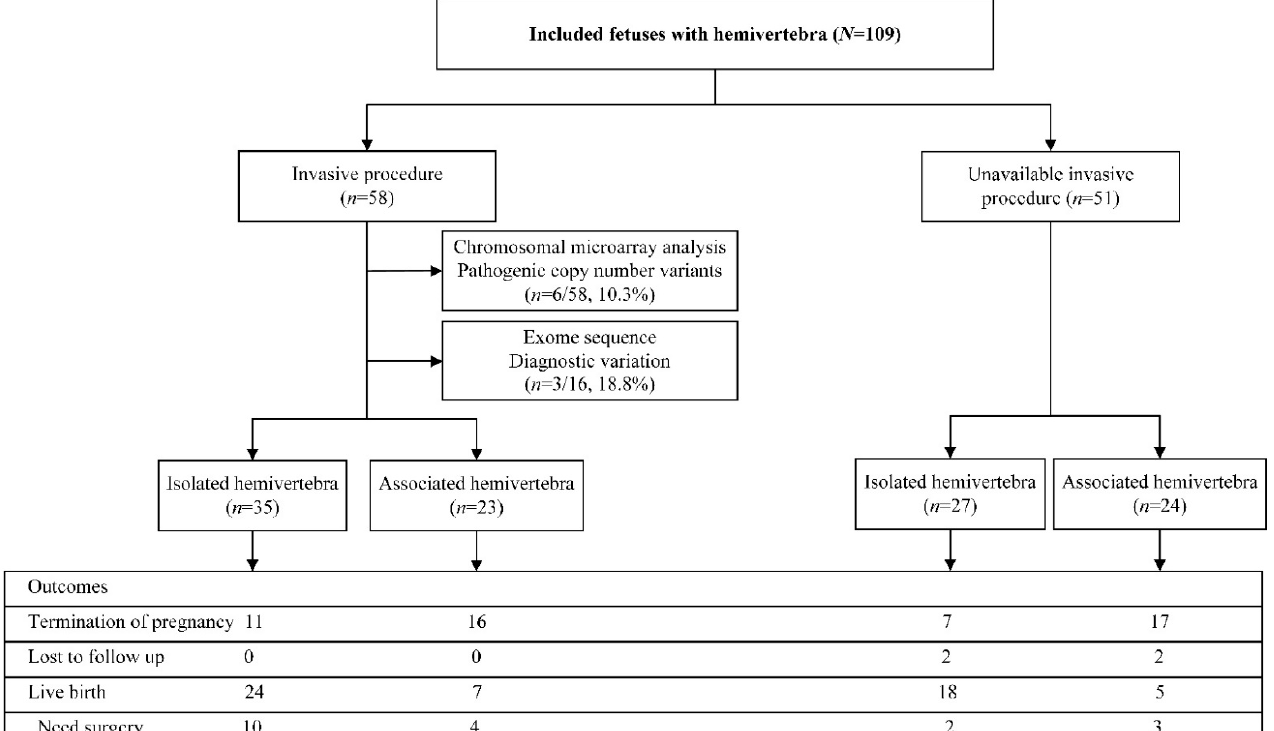
Table 2. Associated anomalies identified sonographically in fetuses with hemivertebra.